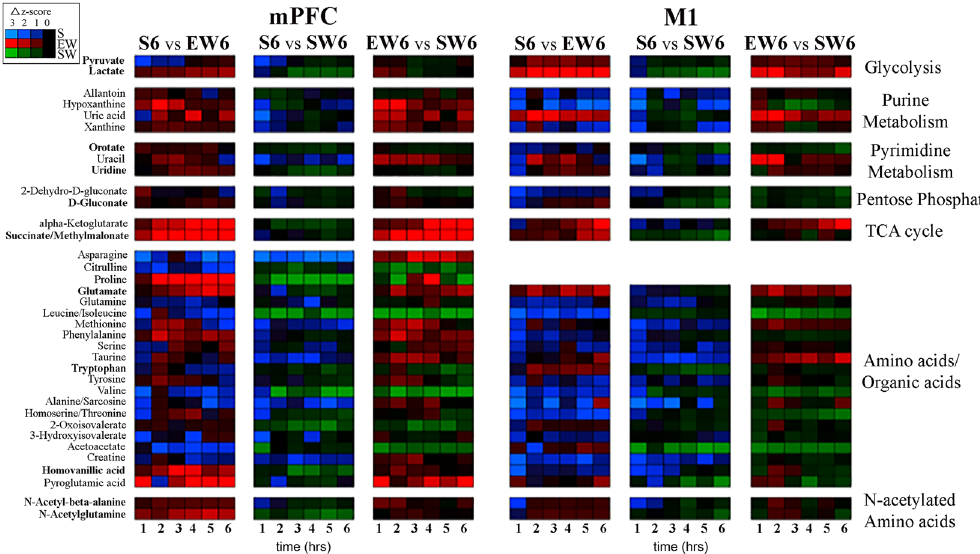
Figure 2. Heatmap analysis. Graphical representation of changes in metabolite levels between microdialysis samples collected from mPFC and M1 expressed as changes in Z score. Each cell represents a 1-hour coarse- grained average ion intensity across the first 6 hours of spontaneous sleep (S6), enforced wakefulness (EW6) or spontaneous wakefulness (SW6). Group comparisons are indicated above each panel. Metabolites (listed at left) are organized by metabolic pathway (listed at right) and listed in bold text when the differences between behavioral states were subsequently identified as statistically significant (LME models). Heatmaps were generated in R with the ggplot2 and colorspace